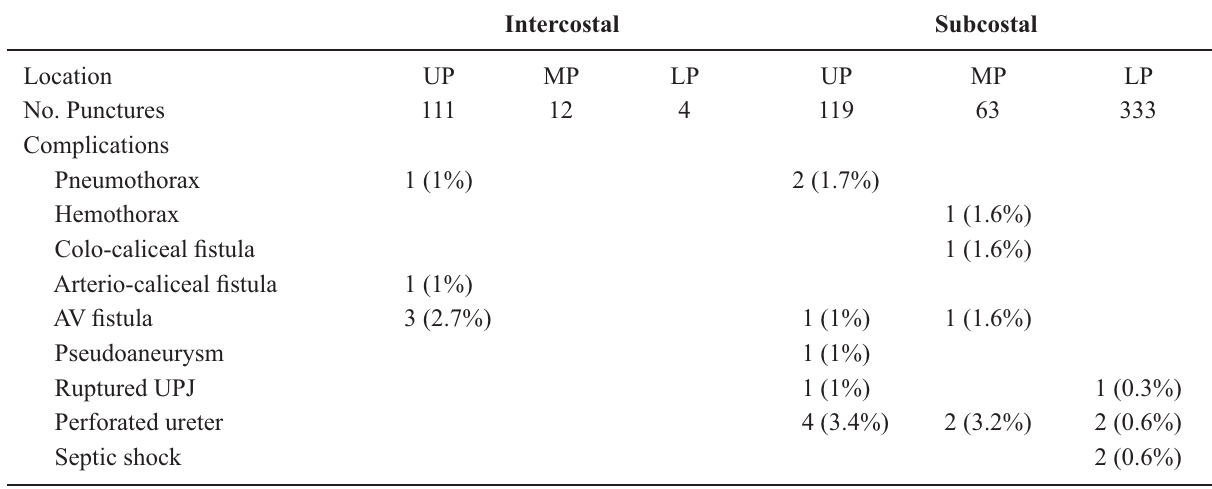
Table 3 – Major complications at various access